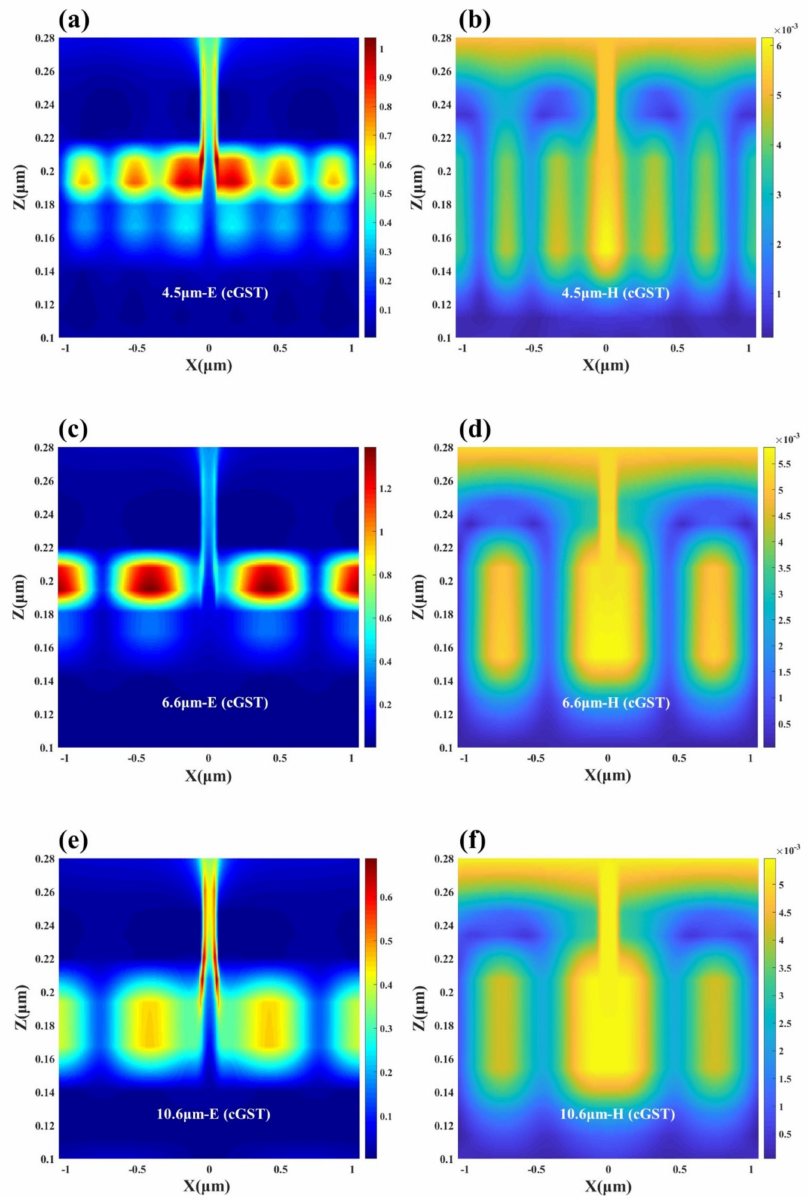
Figure 7. Schematic diagram of the electric and magnetic field distributions of the designed five-layer structure containing cGST thin films ( a , b ) at the first absorption peak, ( c , d ) at the second absorption peak and ( e , f ) at the third absorption